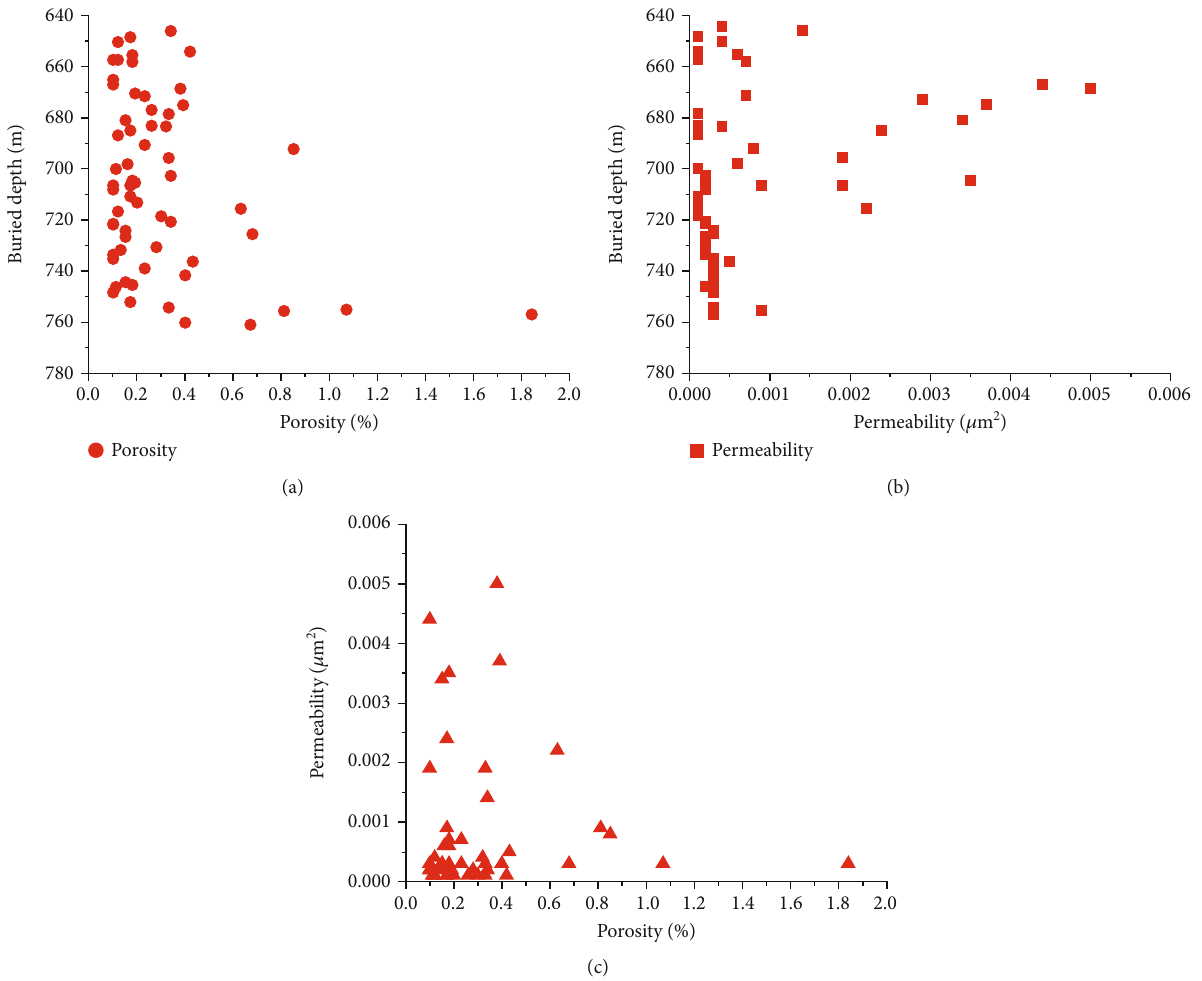
Figure 6: E ff ective porosity (a), permeability (b), and their relationship (c) of WL shale with di ff erent buried depth in